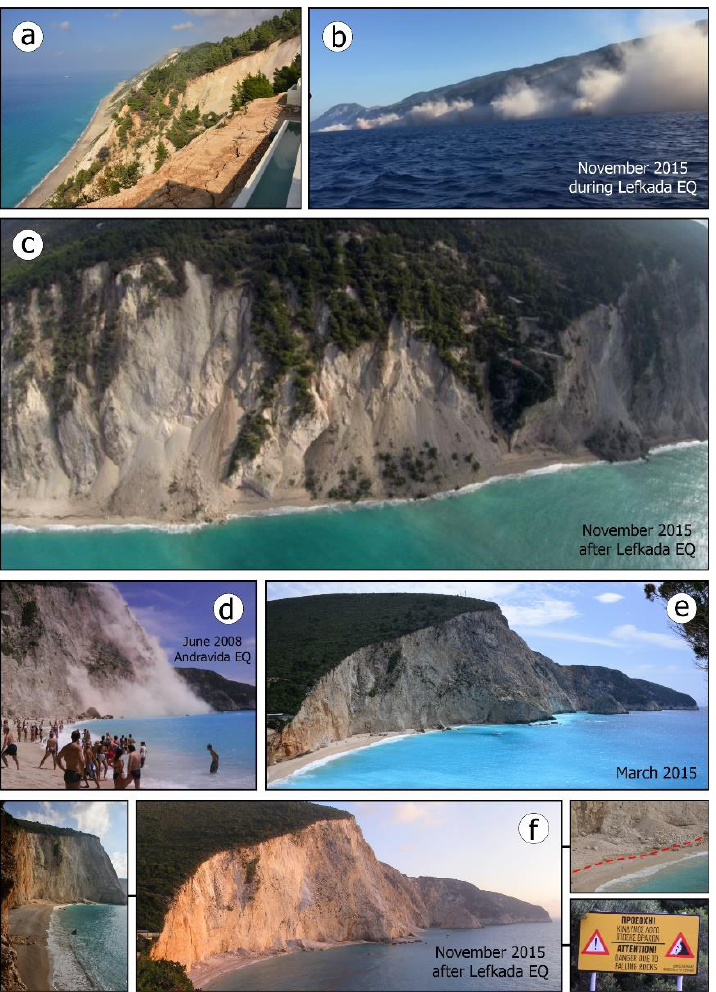
Figure 3. Views of the Egremnoi ( a – c ) and Porto Katsiki ( d – f ) slopes in the southwestern part of Lefkada Island. ( a ) The Egremnoi slope and the adjacent impressive beach were heavily affected by the 2015 Mw = 6.4 Lefkada earthquake. Extended landslides were induced ( b ) and covered almost the entire longitudinal narrow beach ( c ) leaving only small parts intact and inaccessible after the earthquake. Due to the fact that the shock occurred in November, the beach was empty, and no effects were reported to people. However, the road leading from the upper parts of the slope to the beach was totally destroyed and houses founded on the slope were found on the edge of the cliff and on the verge of collapse. ( d ) The Porto Katsiki slope has been affected not only by nearby earthquakes but also by distant earthquakes. The 8 June 2008, Mw = 6.8 earthquake with the epicenter located 110 km southeast of Porto Katsiki triggered rockfalls in the southern segment of the slope, while the mobilized material ended up on the adjacent part of the beach fortunately without fatalities and injuries. ( e ) Boulders and smaller fragments are concentrated mainly in the southern part of the beach. ( f ) Rockfalls triggered by the 17 November 2015, Mw = 6.4 Lefkada earthquake. They were mainly generated in the southern segment of the slope, while they were limited or absent in the central and the northern segment respectively. Since 2015, protection marking on the beach with poles and ropes (red dashed line) and rockfall warning signs have been placed for the safety of visitors.